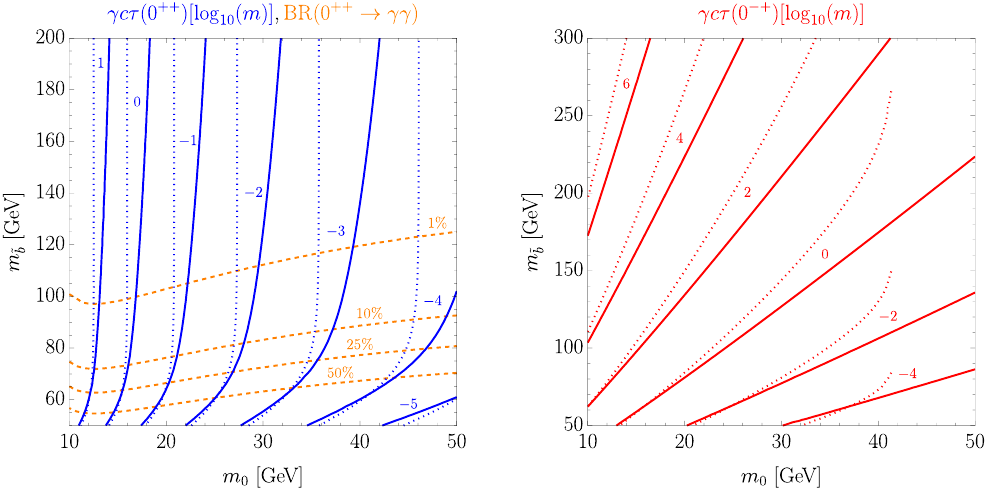
Figure 5 . (Left) Branching ratio of the lightest glueball 0 ++ to diphotons (orange) and lab decay length (blue) from production via either Higgs decays (dotted) or (cid:17) (cid:0) + decays (solid), for (cid:24) = 0 : 1. (Right) Lab decay length of the lightest parity-odd glueball 0 (cid:0) + (red), of mass m from production via either Higgs decays (dotted) or (cid:17) (cid:0) + decays (solid). The decay lengths have been computed under the assumption that the parent particle produces two glueballs only, thus they should be understood as upper